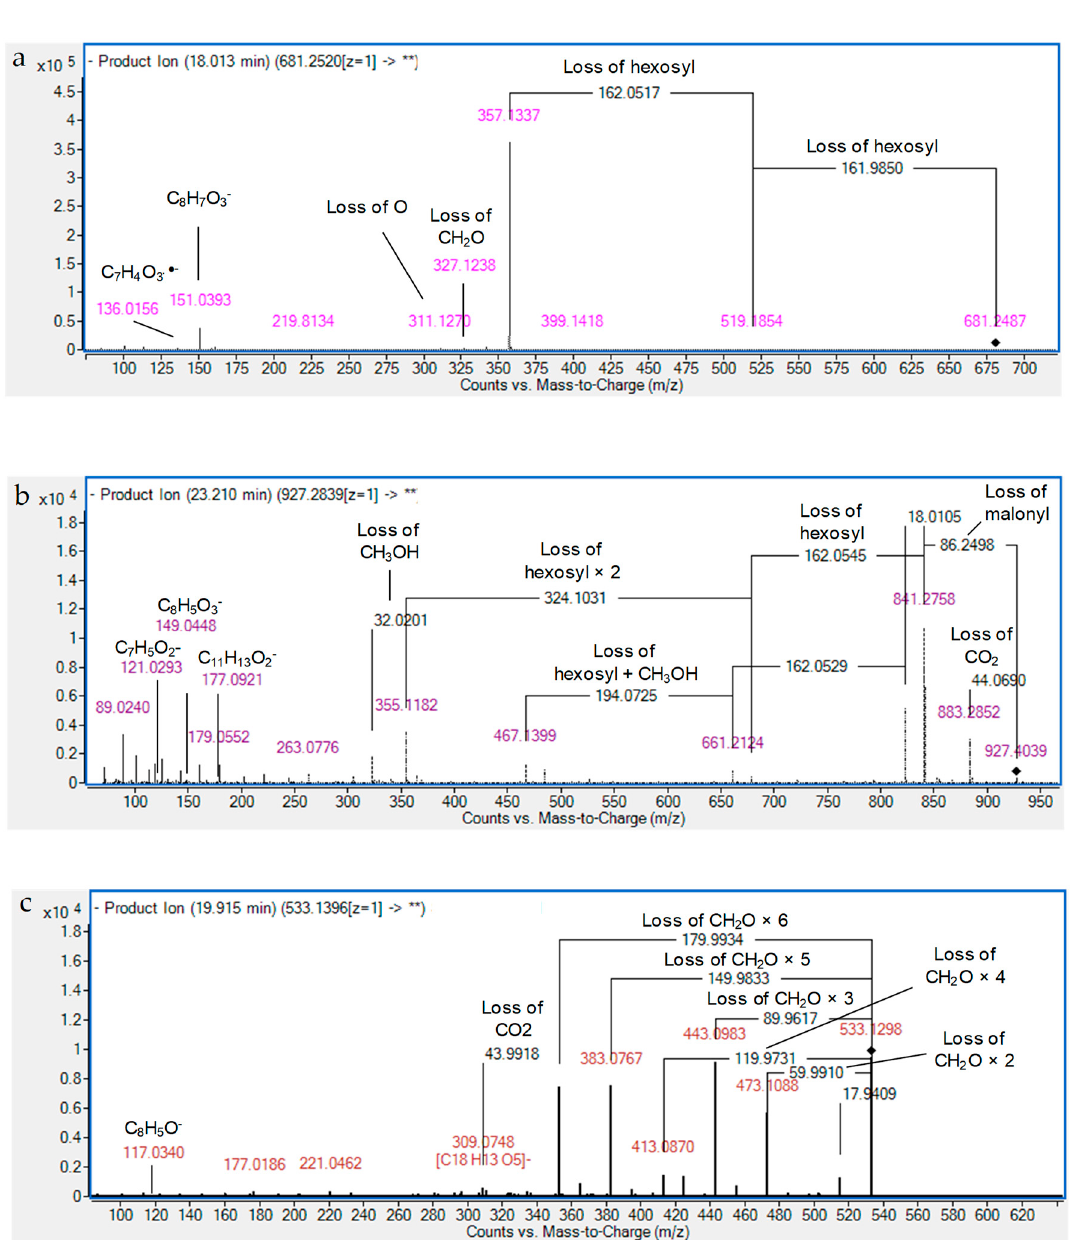
Figure 3. Patterns of ( a ) pinoresinol dihexoside I, ( b ) xanthoxylol malonyl trihexoside, and ( c ) apigenin di- C -pentoside II.